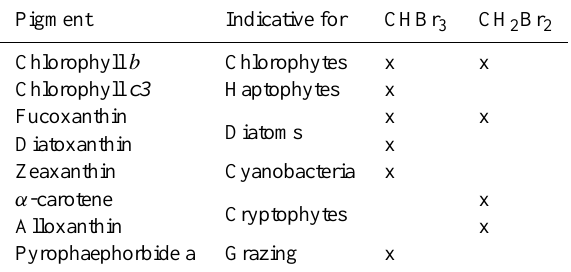
Table 5. Phytoplankton pigments that were found to be significant at p <0.05 and what they are indicative